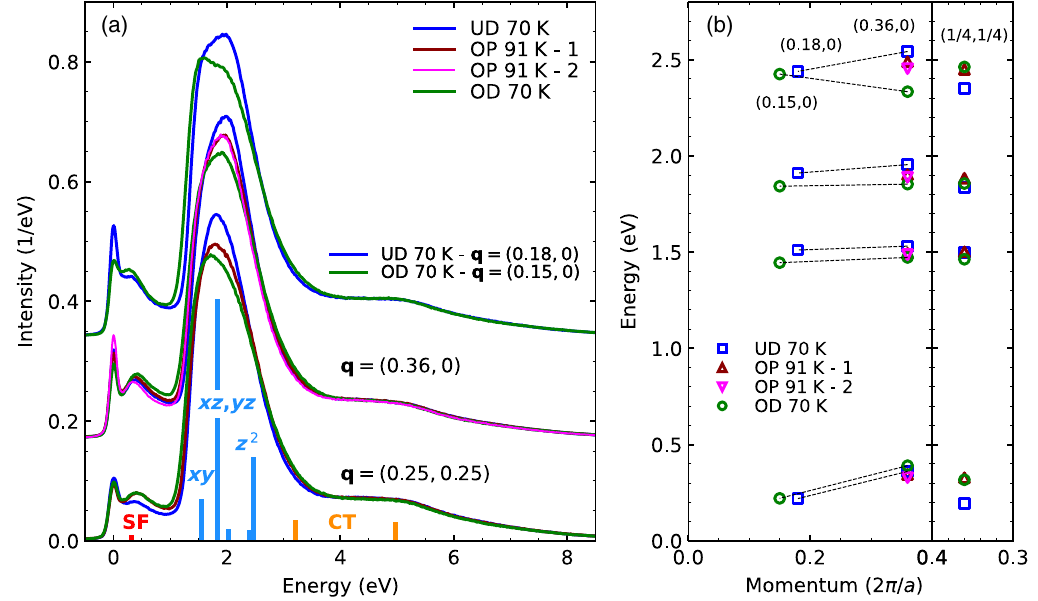
FIG. 1. (a) Experimental RIXS spectra for the three different dopings and for different momentum transfers. To avoid clutter the spectra have been given vertical offsets grouped according to the momentum values. Vertical bars correspond to spin flip (SF, red), dd excitons (blue), and charge transfer (CT) excitations (orange) obtained from a cluster calculation (see Appendix B). (b) Energy- momentum dispersion of the fitted peak positions. Error bars are smaller than the symbol size and therefore not indicated. Momentum values are indicated on